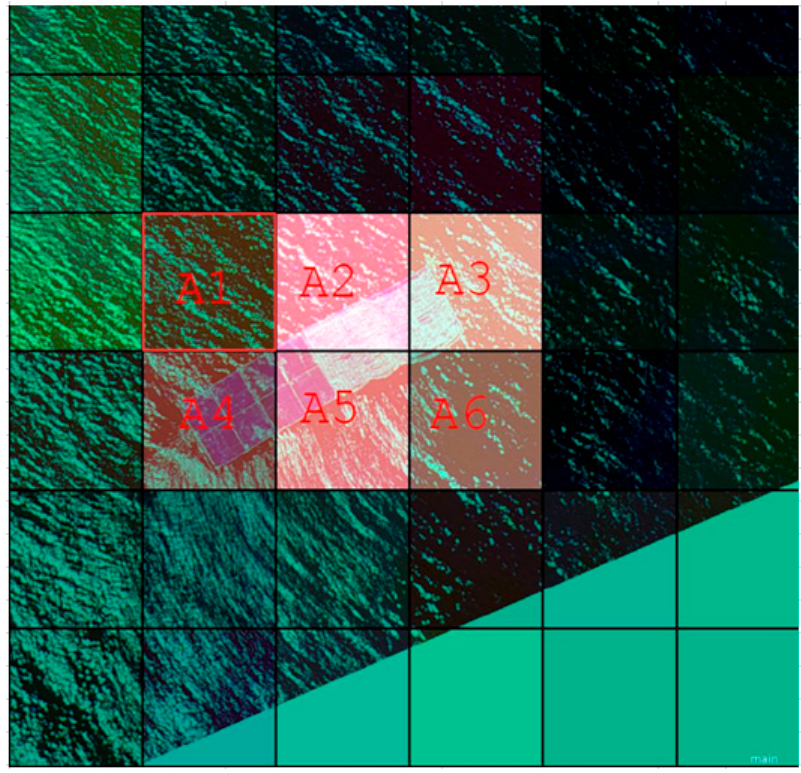
Table 1. Description of the Sentinel-2 level-1 C images that can be used for debris mapping. Image